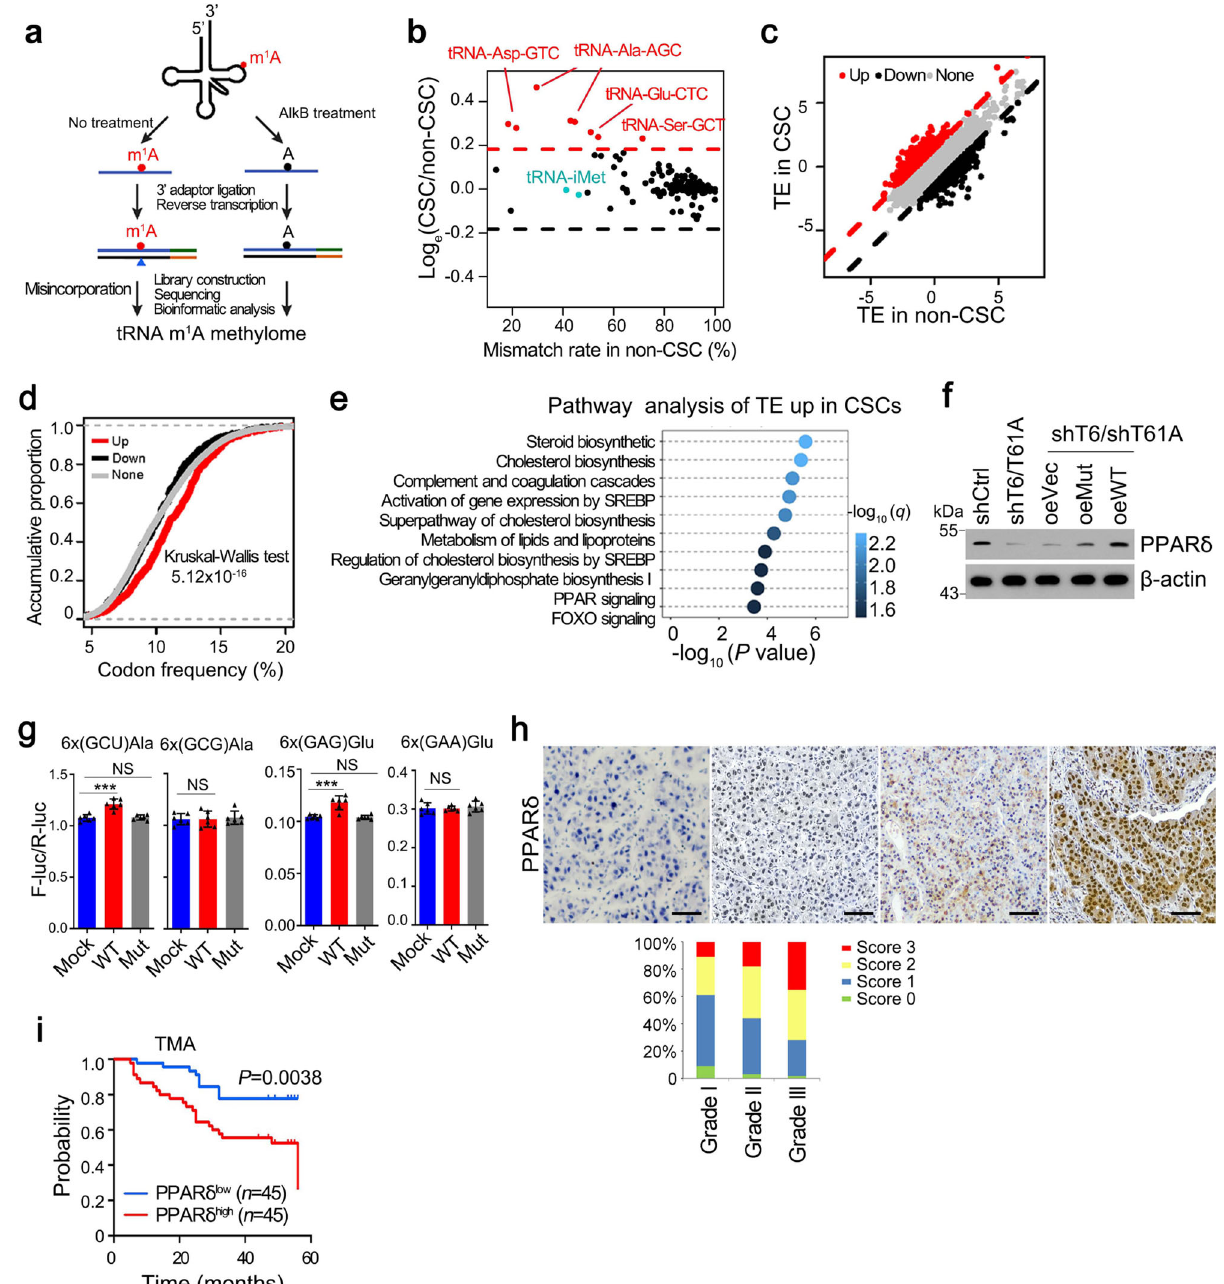
Fig. 3 m 1 A58 methylation in tRNA regulates PPAR δ translation. a Scheme of tRNA m 1 A-seq. b Comparison of misincorporation signals caused by m 1 A58 in tRNAs between liver CSC and non-CSC cells. Red dots represent tRNAs with elevated m 1 A58 methylation levels in CSCs. c Comparison of translation ef fi ciency (TE) between liver CSC and non-CSC cells. Red dots represent genes with increased TE, while black dots represent genes with decreased TE in liver CSCs. d Frequency of codons corresponding to m 1 A58 elevated tRNAs was higher in the genes with increased translation ef fi ciency (TE) in CSCs. e Unbiased pathway analysis of TE upregulated genes in liver CSCs compared with non-CSCs. f Western blotting analysis of PPAR δ expression in indicated CSCs. n = 4 biologically independent samples. g Effect of elevated m 1 A58 methylation levels in tRNA Ala(AGC) and tRNA Glu(CTC) on protein synthesis. Reporter vectors were transfected into Mock overexpressed PLC/PRF/5 cells, WT-TRMT6/TRMT61A or Mut-TRMT6/TRMT61A overexpressed PLC/ PRF/5 cells, respectively. Control vectors were also transfected into these three cell lines to normalize translation differences among these cell lines. The expression level of two synonymous codon control Ala-(GCG) and Glu-(GAA) remained unchanged upon TRMT6/TRMT61A expression level manipulation. n = 6 biologically independent samples. Exact P values from left to right: 0.00021, 0.27, 0.45, 0.00086, 0.21, 0.15. h Representative immunohistochemistry images of PPAR δ (brown) in our cohort of 191 HCC samples. n = 3 independent samples. Scores 0 represents PPAR δ staining that was considered negative, Scores 1 represents PPAR δ staining that was considered negative, whereas scores 2 and 3 represent PPAR δ staining that was considered positive. Grade I ( n = 56), Grade II ( n = 87), Grade III ( n = 48). Scale bar, 100 μ m. i Kaplan – Meier plots of overall survival for PPAR δ in TMA cohort. Median expression value was used as a cut-off. P values for Kaplan – Meier curves were determined using a two-sided log-rank test. *** P < 0.001, and NS not signi fi cant ( P > 0.05) by two-tailed Student ’ s t -test.